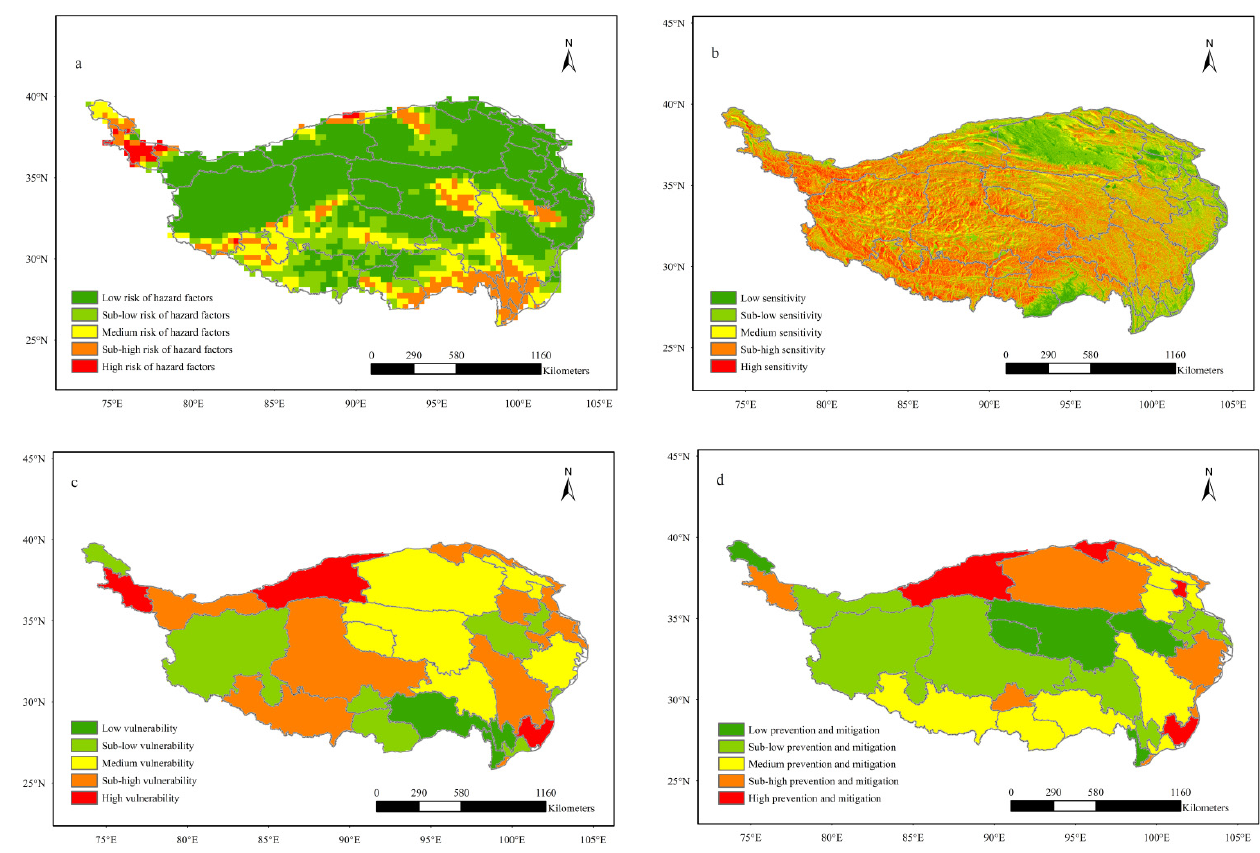
Figure 8. Zoning of the risk of hazard factors ( a ), sensitivity of hazard-inducing environments ( b ), vulnerability of hazard-affected bodies ( c ), and disaster prevention and mitigation capacity ( d ) of snow disasters for husbandry on the QTP.